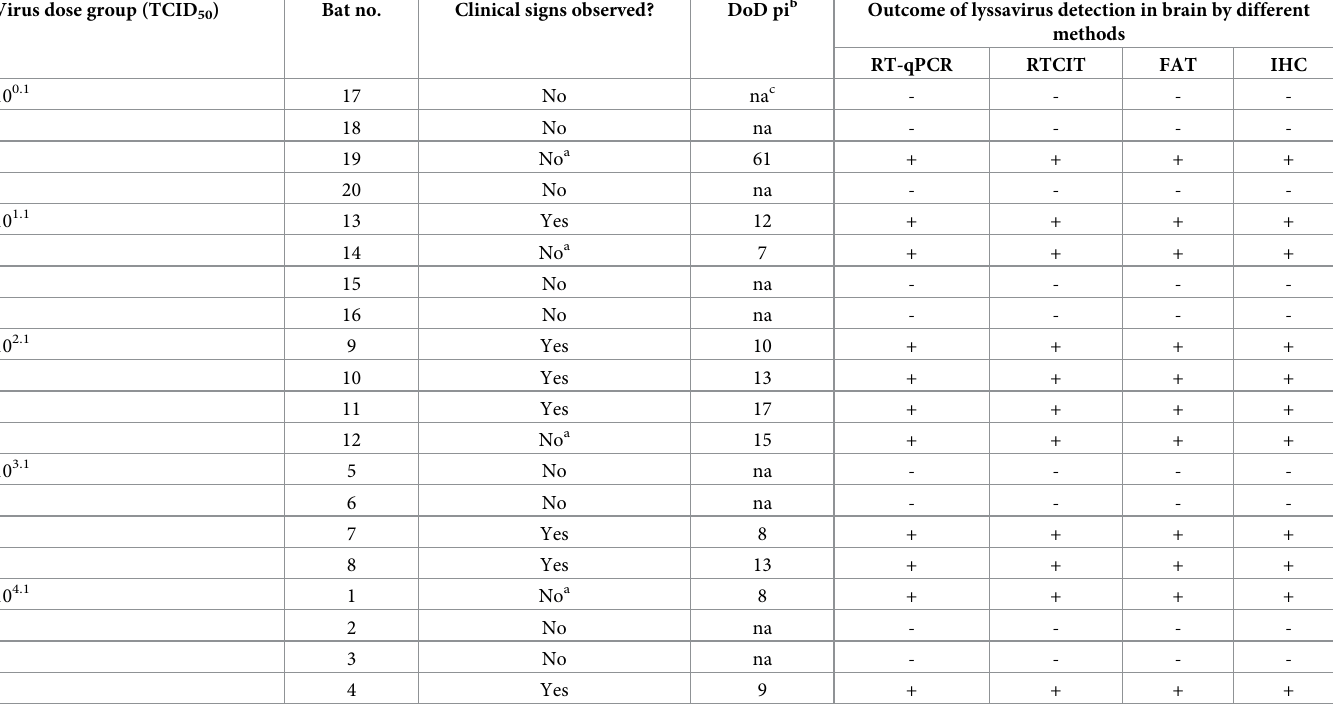
Table 1. Association between clinical outcome and detection of lyssavirus in the brains of straw-colored fruit bats inoculated with different doses of Lagos bat virus. Virus dose group (TCID 50 ) Bat no. Clinical signs observed? DoD pi